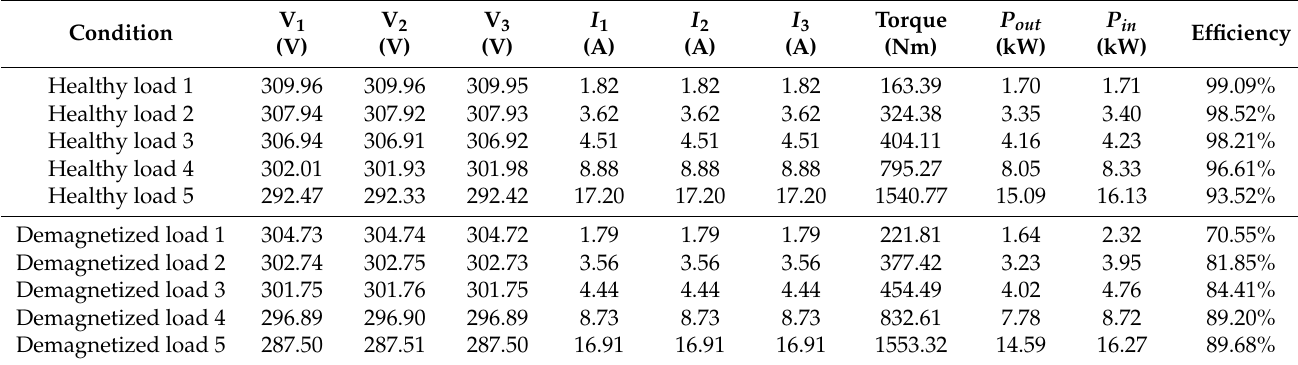
Table 3. Simulation measurement